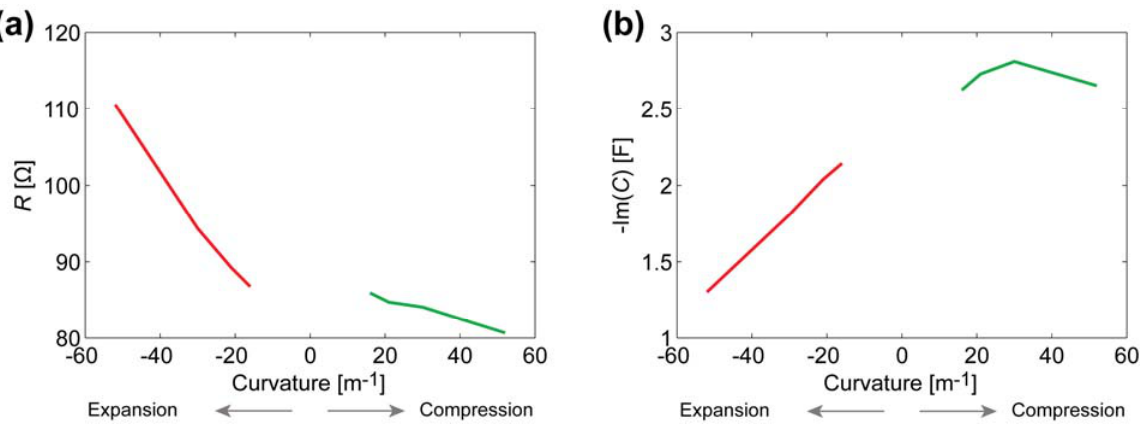
Figure 8. ( a ) The correlation between the surface resistance and the curvature of a CPC at the frequency of 0.2 Hz; ( b ) The correlation between the apparent surface capacitance and the curvature of a CPC at the frequency of 0.2